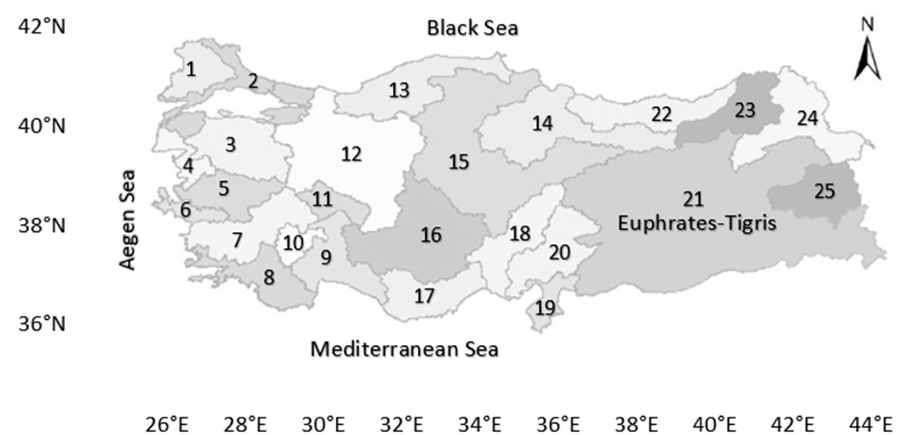
Figure 1. Hydrological river basins in Turkey.